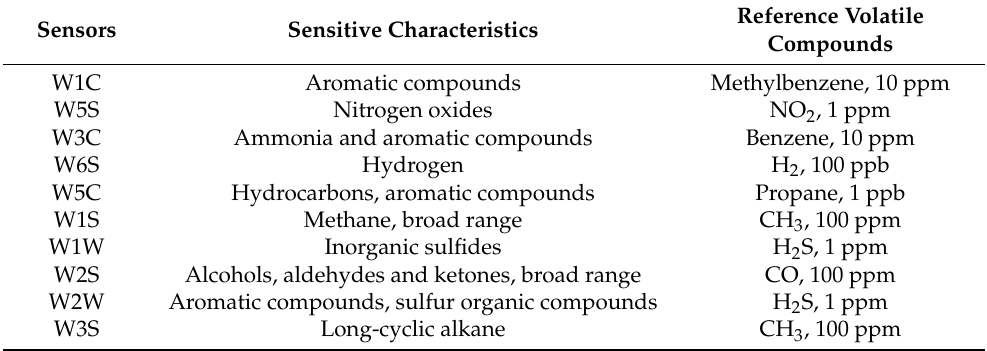
Table 2. Sensors used and their performance descriptions in PEN3 electronic